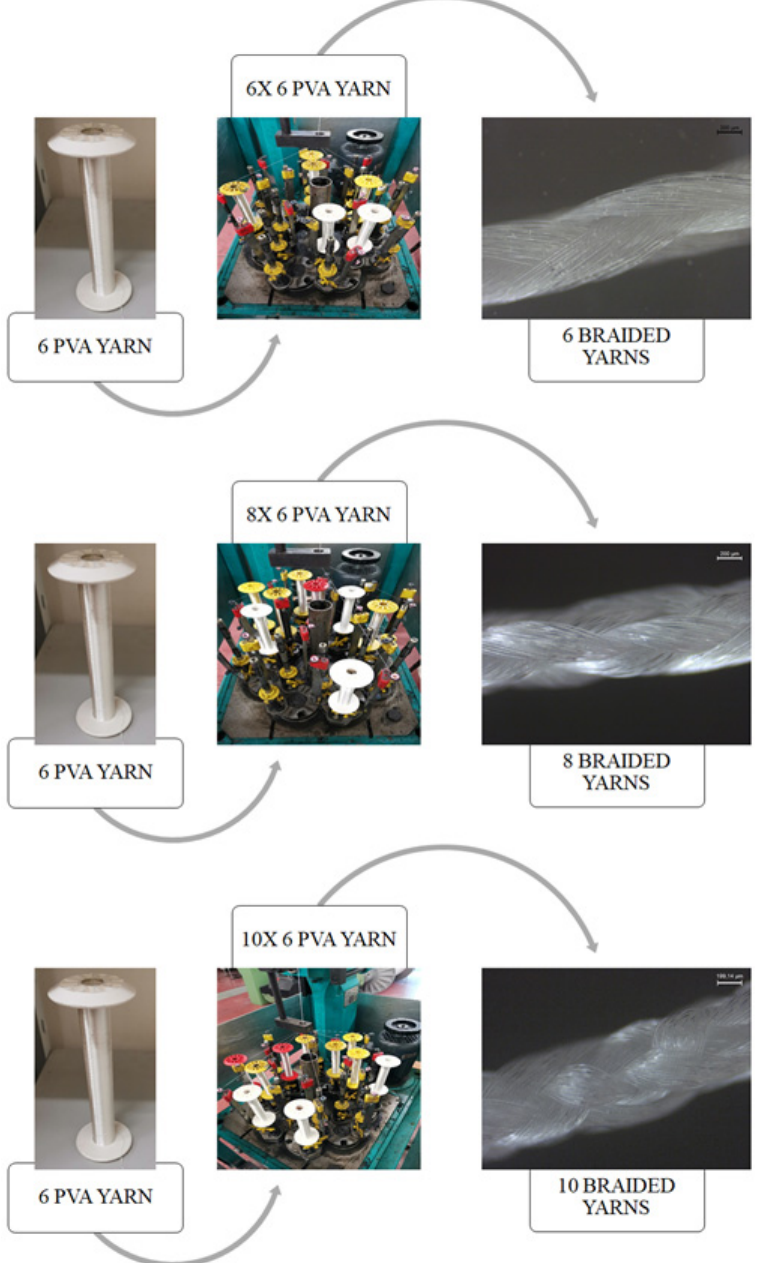
Figure 2. Production process of PVA 6, 8, and 10 braided yarns and the respective microscopic